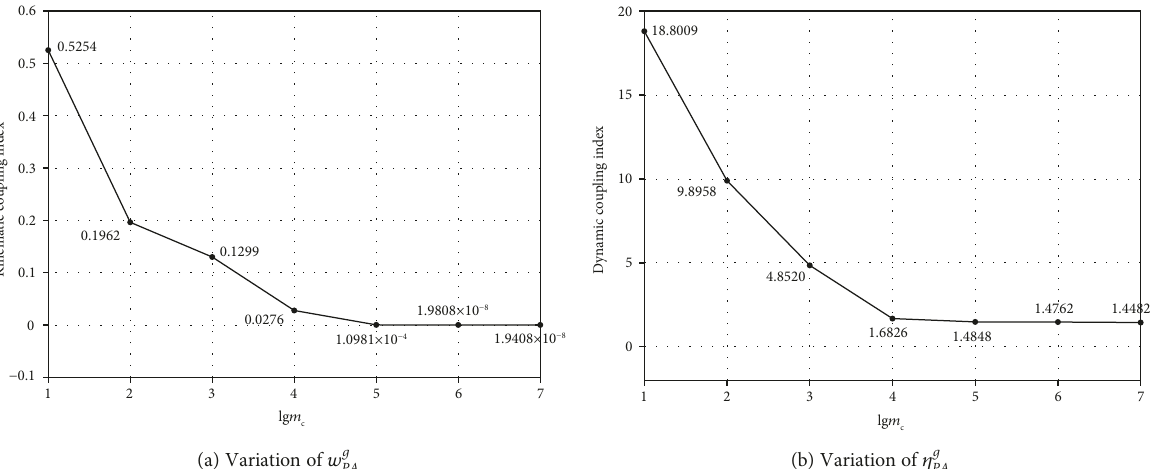
Figure 11: The variations of w g